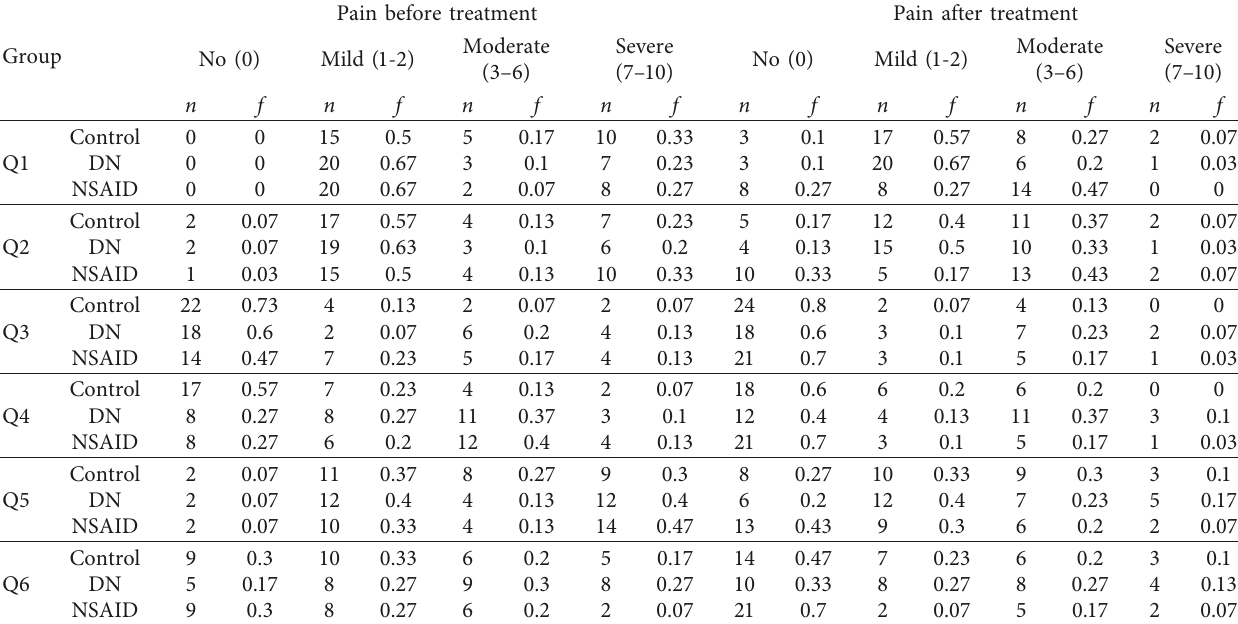
Table 2: Answer data in simplified scale (analysis of VAS and Sleep and Pain Activity Questionnaire for each question and group).